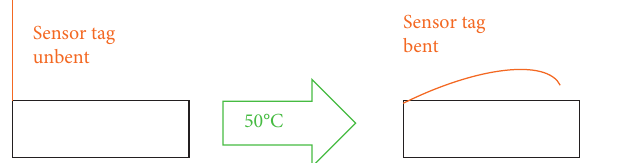
Figure 6: The bending process of the TRF filament and sensor tag from its unbent state to its bent state after exposure to the higher temperature.